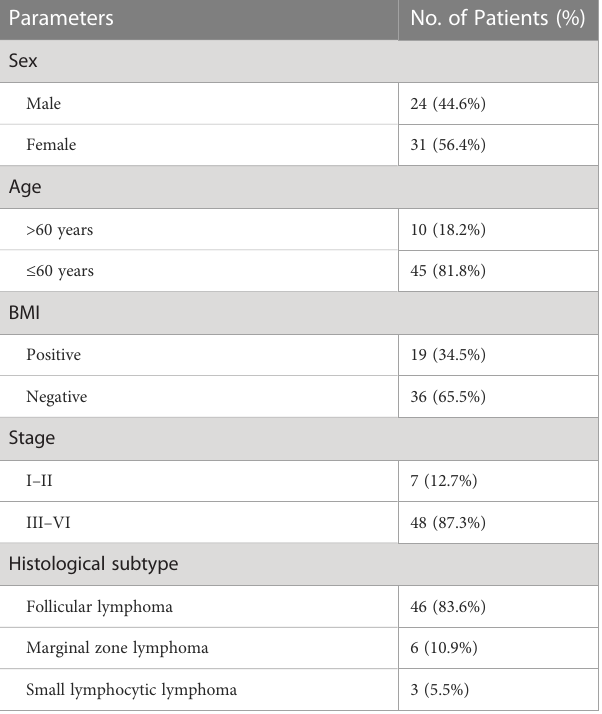
TABLE 1 Clinical characteristics of 55 patients with indolent lymphoma.